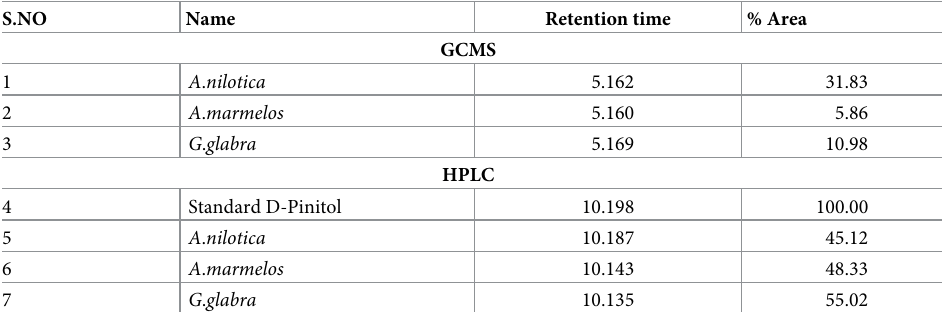
Table 1. GCMS and HPLC analysis of D-Pinitol with the retention time and percentage area of the HXM plant extracts.